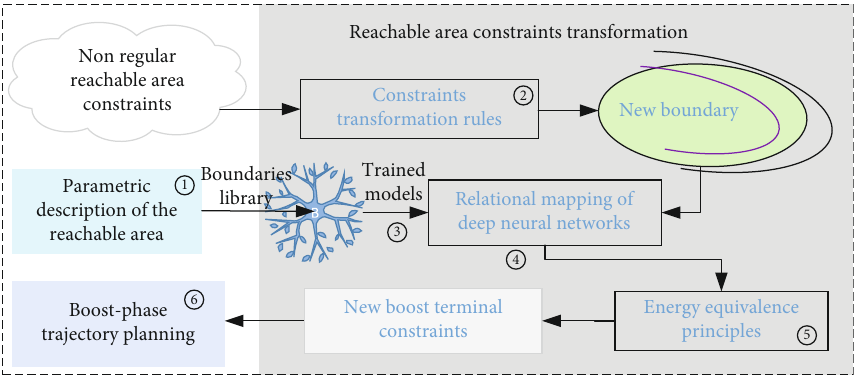
Figure 1: Methodological framework.